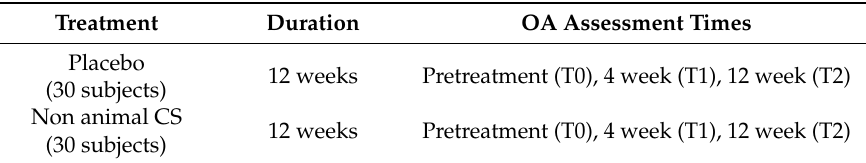
Table 1. Experimental design of the